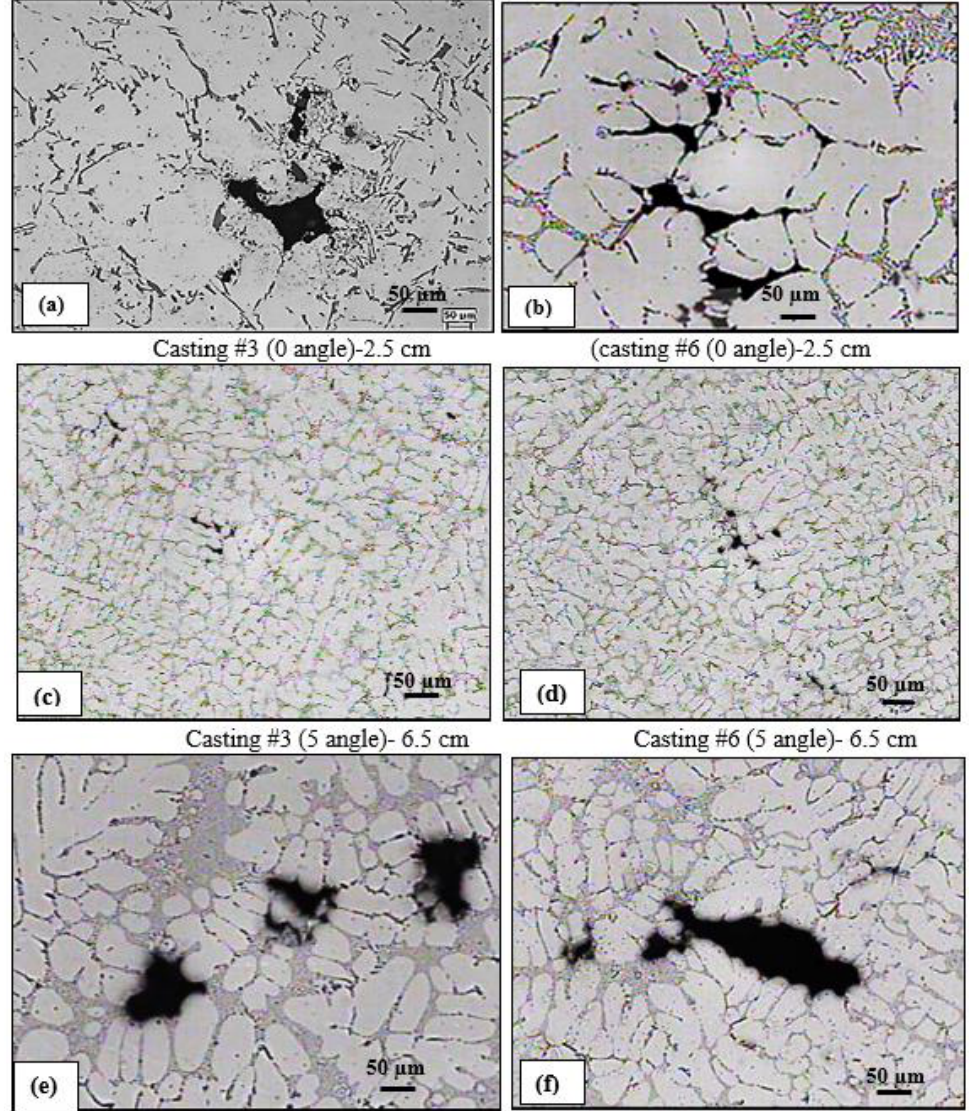
Figure 5. ( a – f ) Effect of solidification rate (measured as a function of distance from the mold bottom) on porosity formation in base alloys. Casting #3 (B alloy), casting #6 (C alloy).